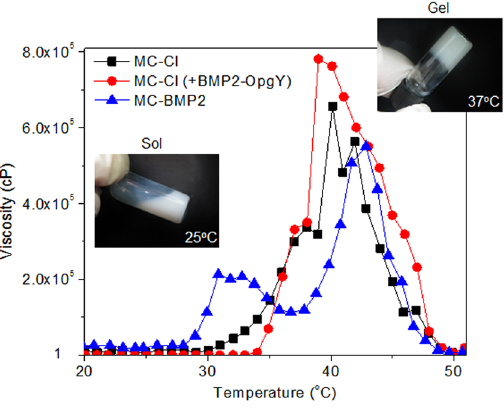
Figure 4. Viscosity vs. temperature curves of MC-Cl, MC-Cl ( + BMP2-OpgY), and MC-BMP2.